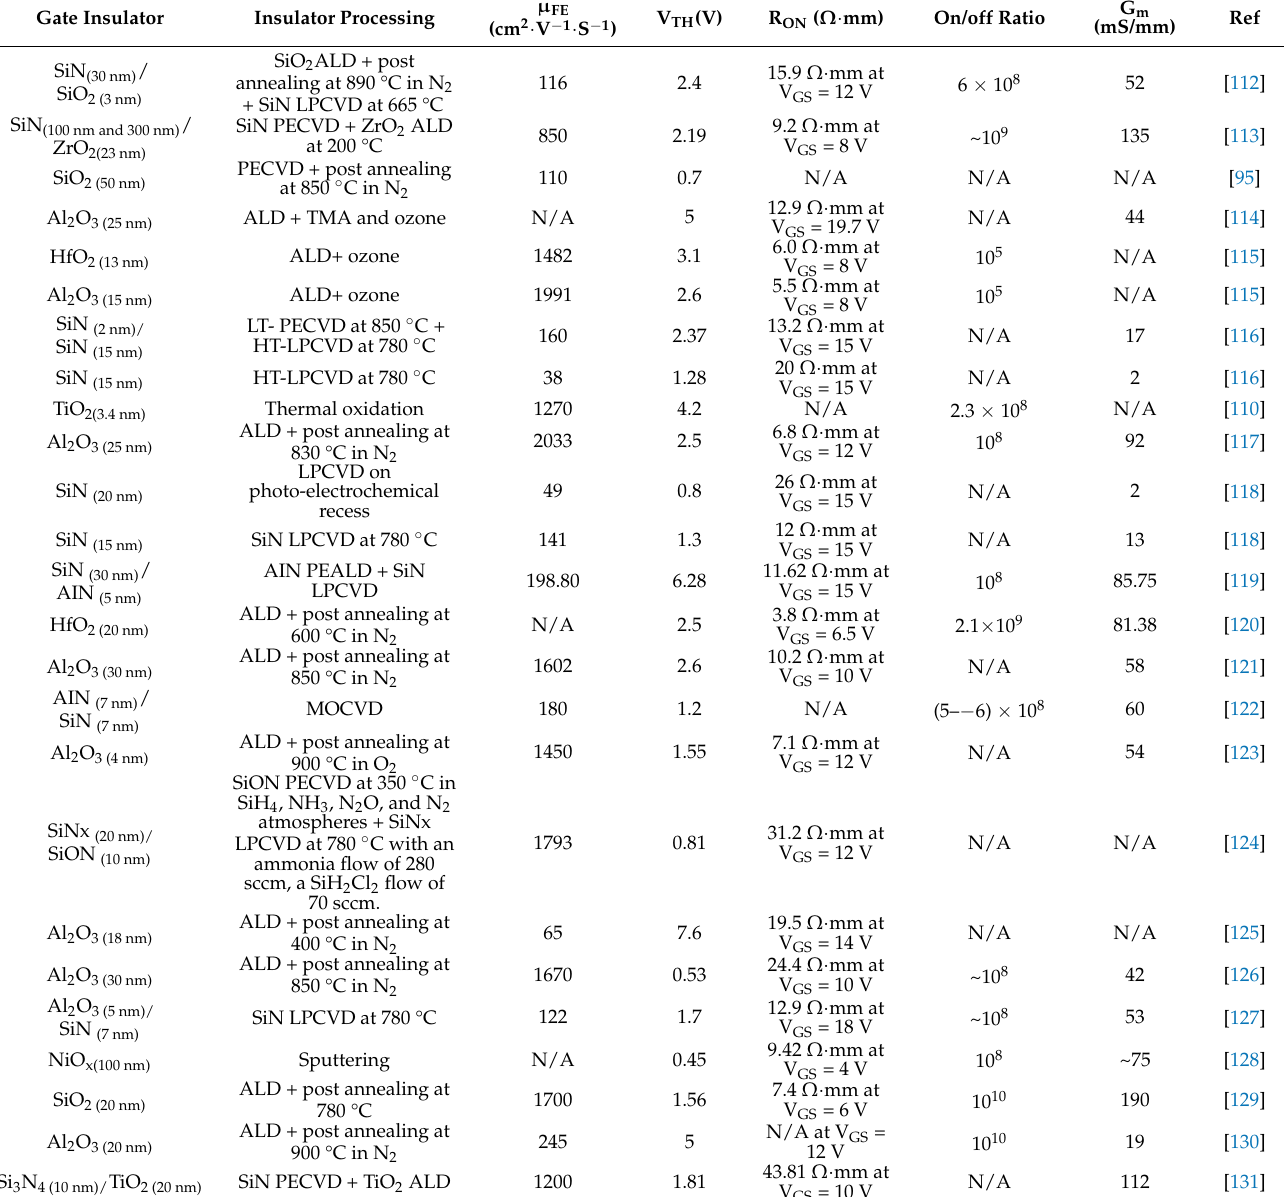
Table 4. Survey literature data on difference types of gate insulators and